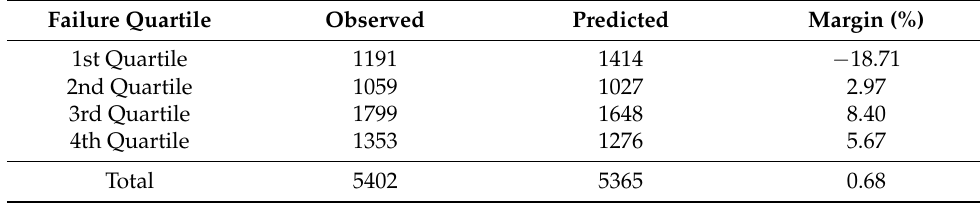
Table 7. Quartile of the pipe failures with ML